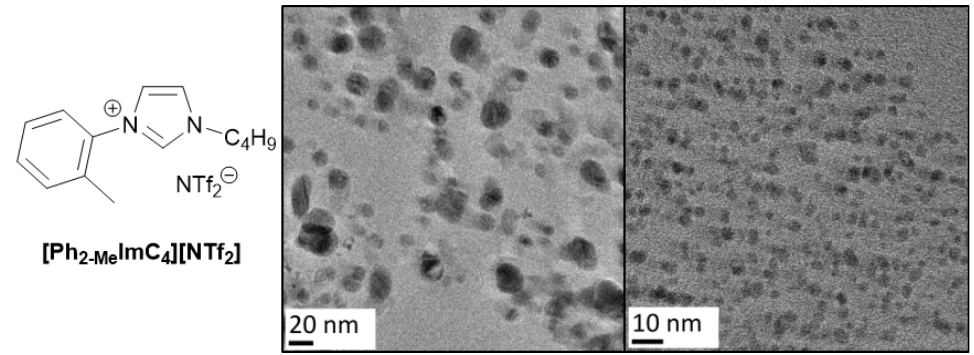
Figure 6. TEM images of the sample MP4_rGO-1/1 obtained after 5k stability test. Images were measured with an FEI Titan 80–300 TEM.